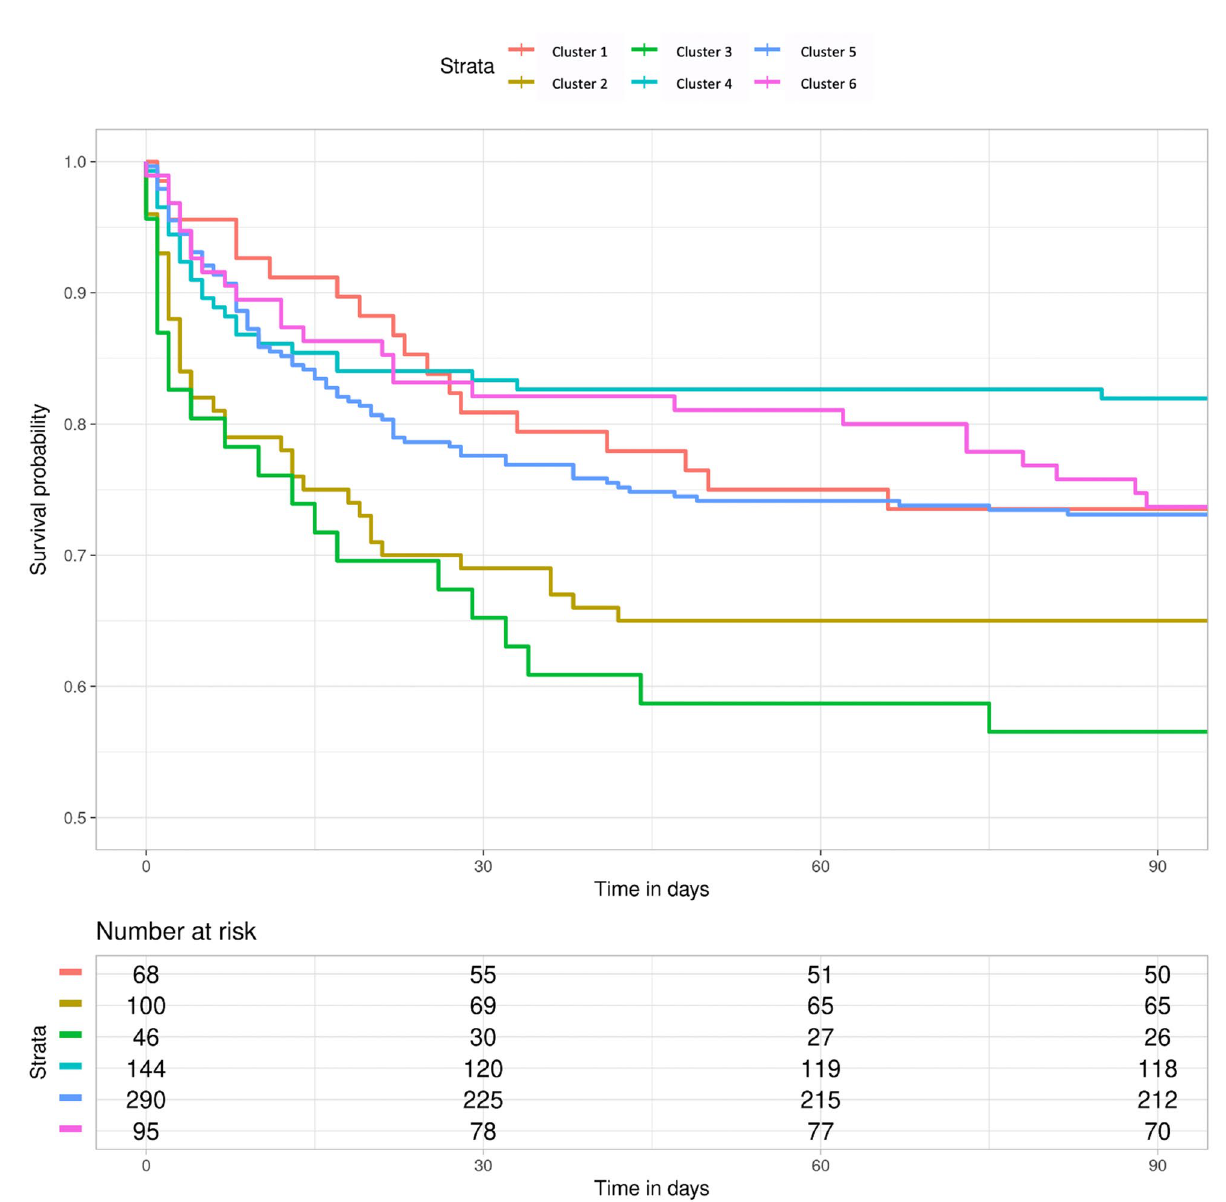
Figure 4. Kaplan–Meier curves stratified per cluster for mortality during and after ICU stay. Survival curves for all six clusters, with the number of patients at risk at 30 and 90 days per